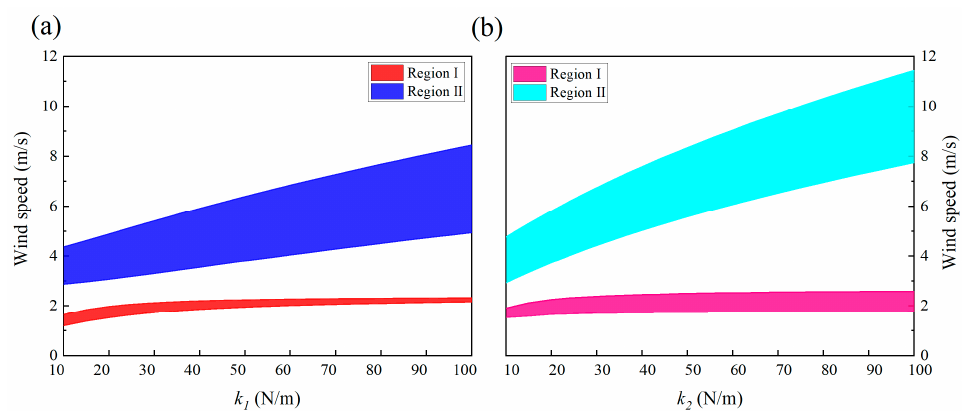
Figure 20. Effects of damping coefficients on the “lock-in” regions of the 2DOF VIVPEH: ( a ) c 1 and ( b ) c 2 .